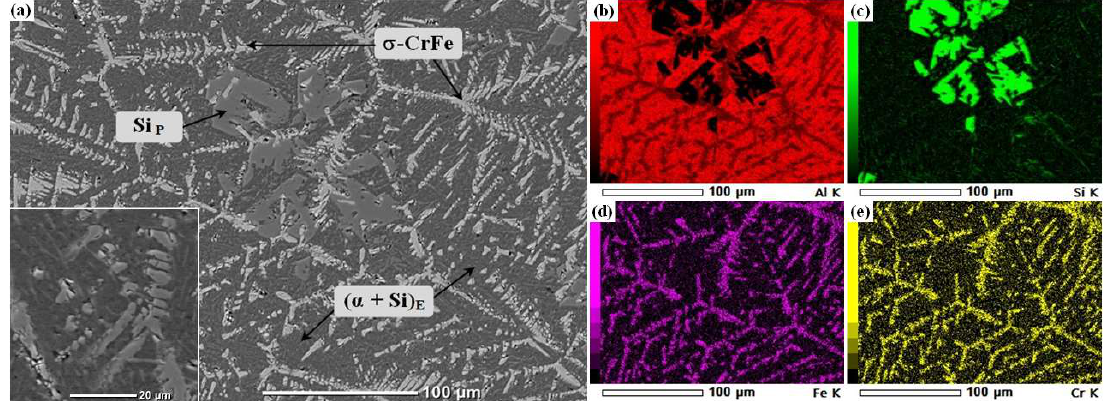
Figure 4. ( a ) Backscattered electron image of AlSiFe with 3 wt. % Cr, eutectic microstructure as insert. Elemental mapping of ( b ) aluminum, ( c ) silicon, ( d ) iron, and ( e ) chromium. Si p = Primary silicon, (α+Si) E = Eutectic.